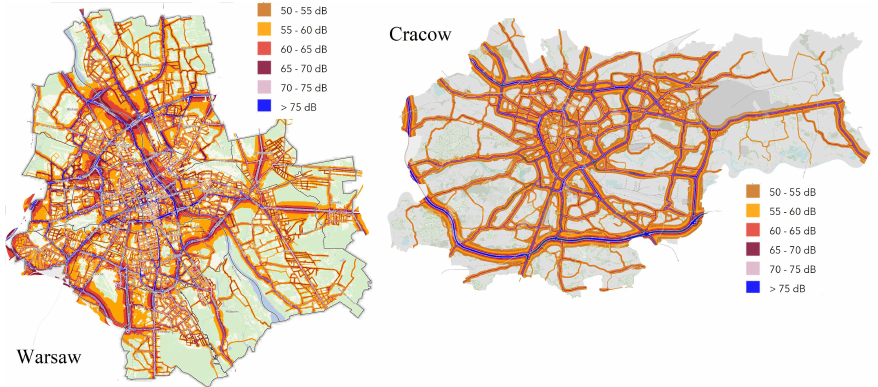
Figure 3. Acoustic maps of Warsaw and Cracow – 2017 [38,39].